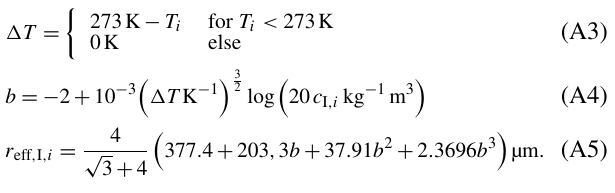
For layer i , r eff , L ,i is the effective radius, c L ,i the liquid wa- ter content, N = 150 × 10 6 the droplet density, and ρ H 1000 kg m − 3 the water density at 4 ◦